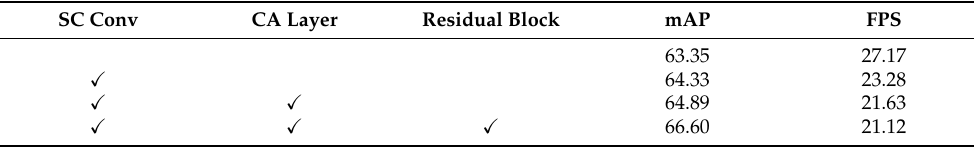
Table 4. Ablation study results for different components.